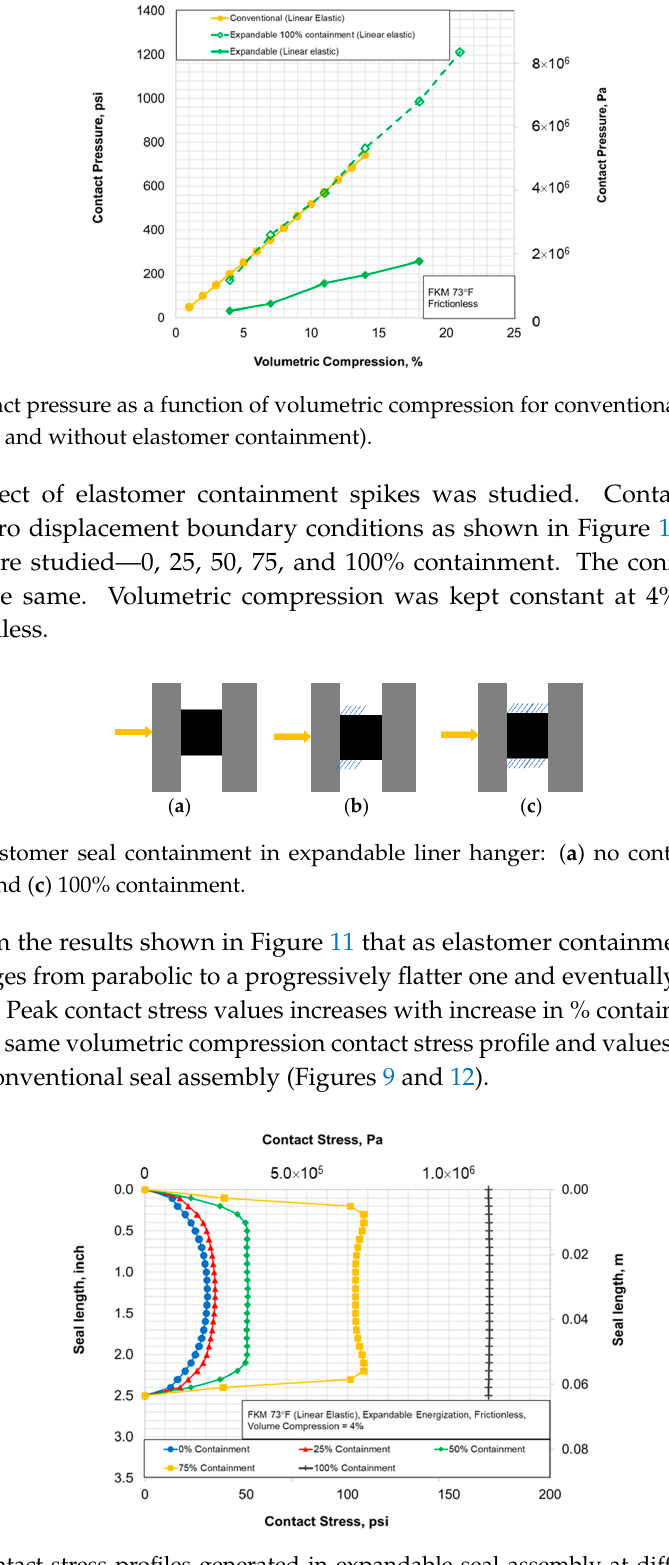
Figure 12. Contact stress profiles generate in expandable seal assembly with 100% containment and different volumetric compression. 6.2. Effect of Material Behavior Next, the effect of material behavior was studied. Specifically, hyper-elastic material behavior of FKM (Ogden 3rd order) was modelled and resultant contact stress profiles were compared with the ones generated using linear-elastic material behavior. Contact stress profiles using the hyper-elastic FKM for conventional and expandable assembly without containment are presented in Figures 13 and 14 respectively.